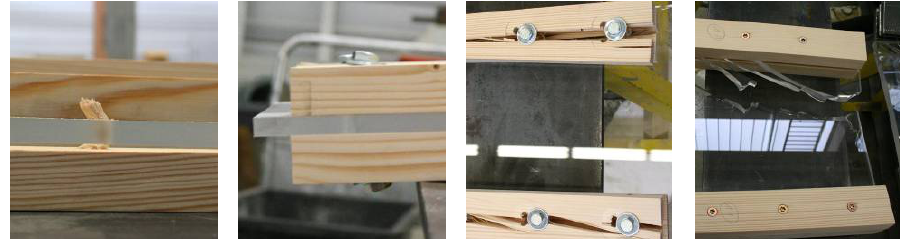
Figure 9a, b, c and d: Various wood PMMA specimens and corresponding failure modes.